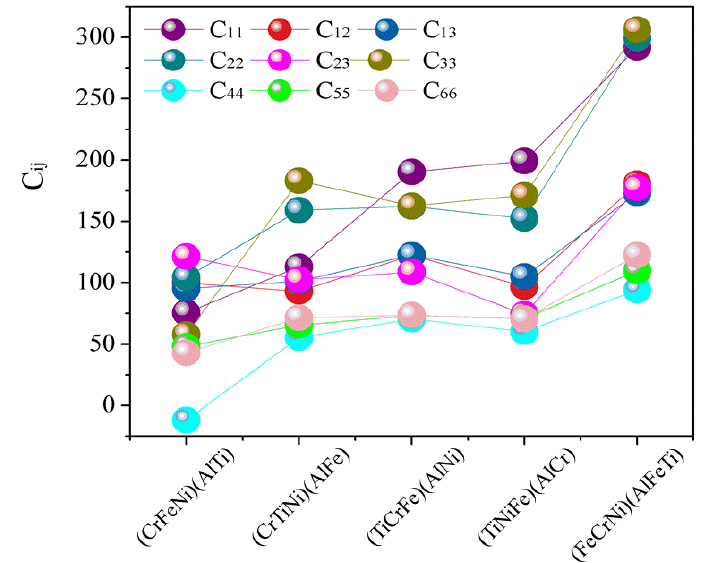
Figure 3. The calculated elastic constants (Cij) for single-phase AlCrTiFeNi of di ff erent atom occupancy positions.